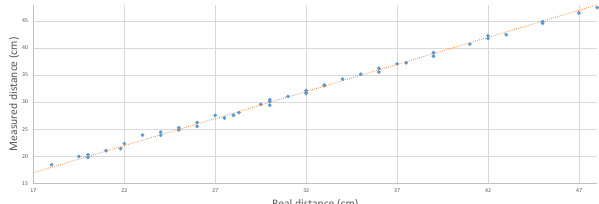
Figure 13. Real vs. Measured Distance between End E˙ector and